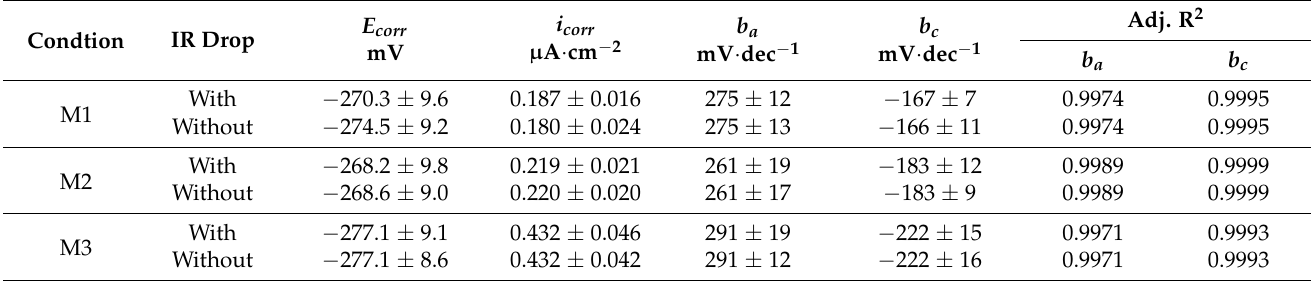
Table 6. Fitting results of polarization curves with and without an IR drop by Tafel extrapolation under three measurements in NaOH solutions after exposure for 2